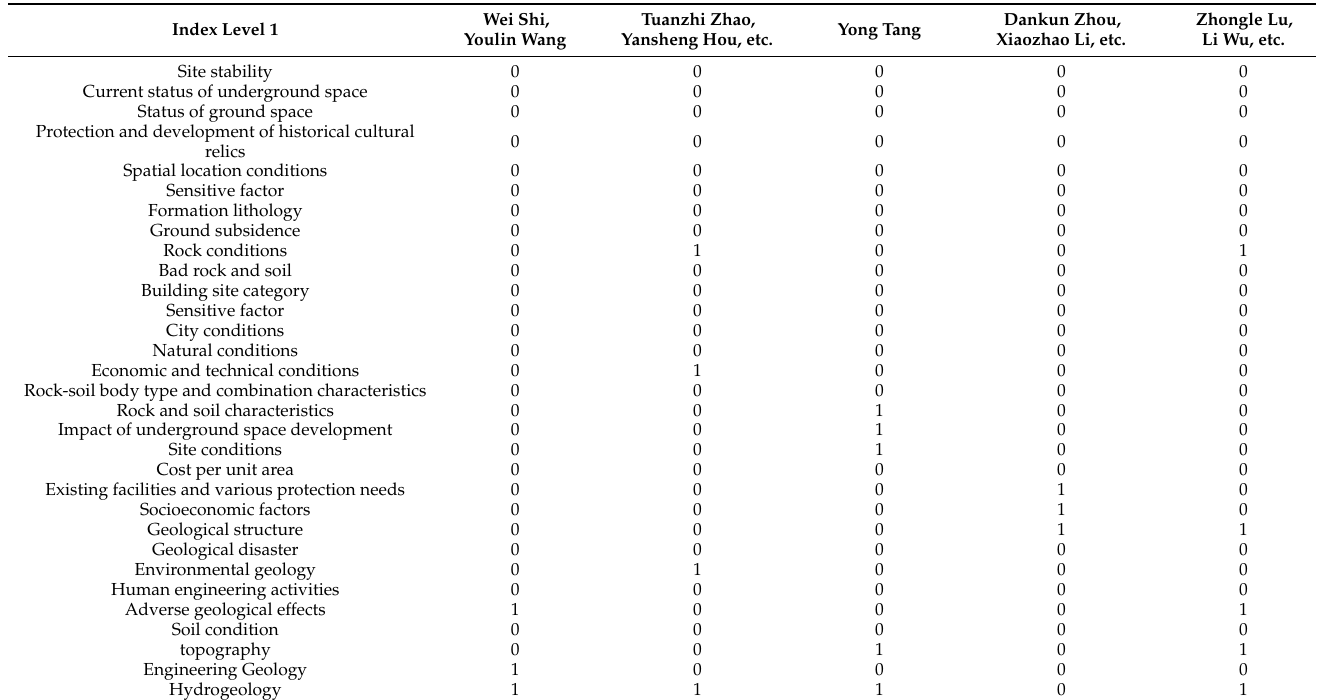
Table A5. First level index binarization